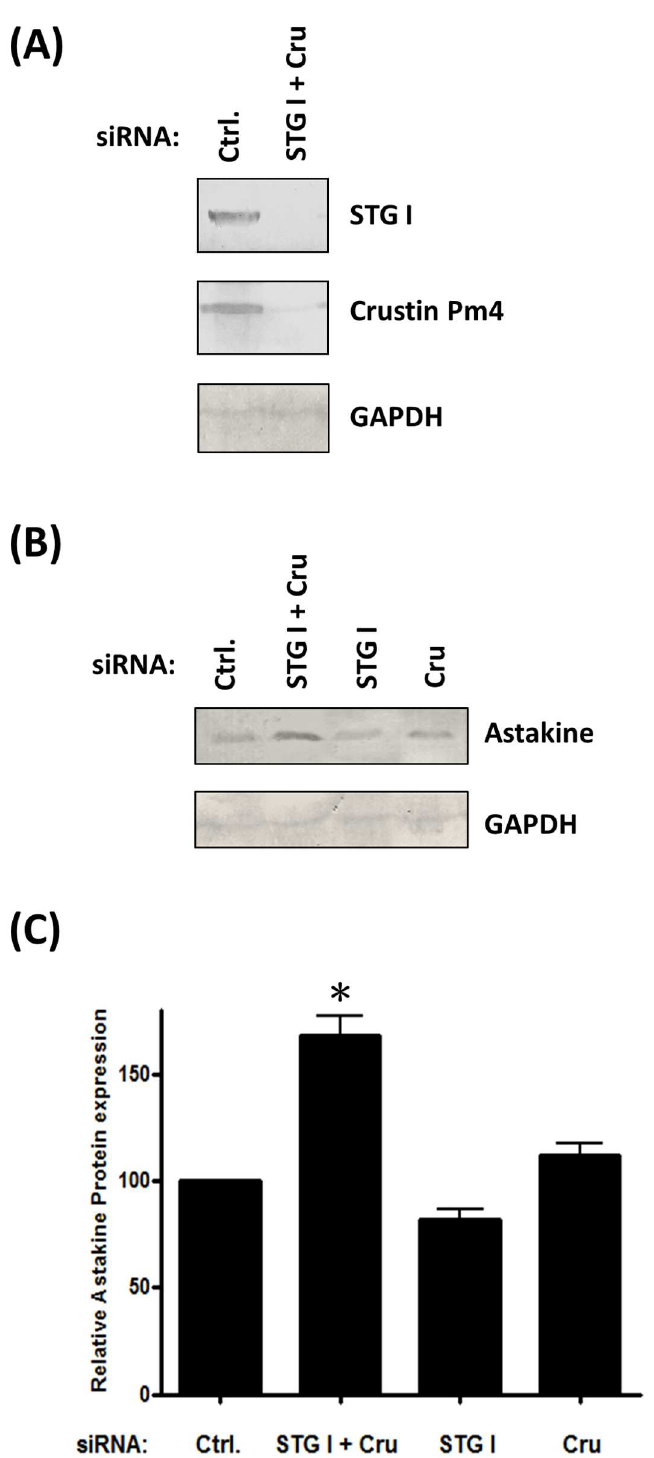
Fig 7. Co-depletion of STG I and crustin Pm4 increasesthe protein level of astakine. (A) siSTG I and siCru co-transfected hemocytes demonstrate a decreasein protein levels of STG I and crustin Pm4. (B) The proteinsfrom siRNA transfected primary culturedhemocyte and medium were collected and extracted for Western blot of astakineexpression. (C) The relative expressionof astakineprotein was quantified by MataMorph ® v7.0 software using GAPDH as internalcontrol (n = 7). Astakine protein